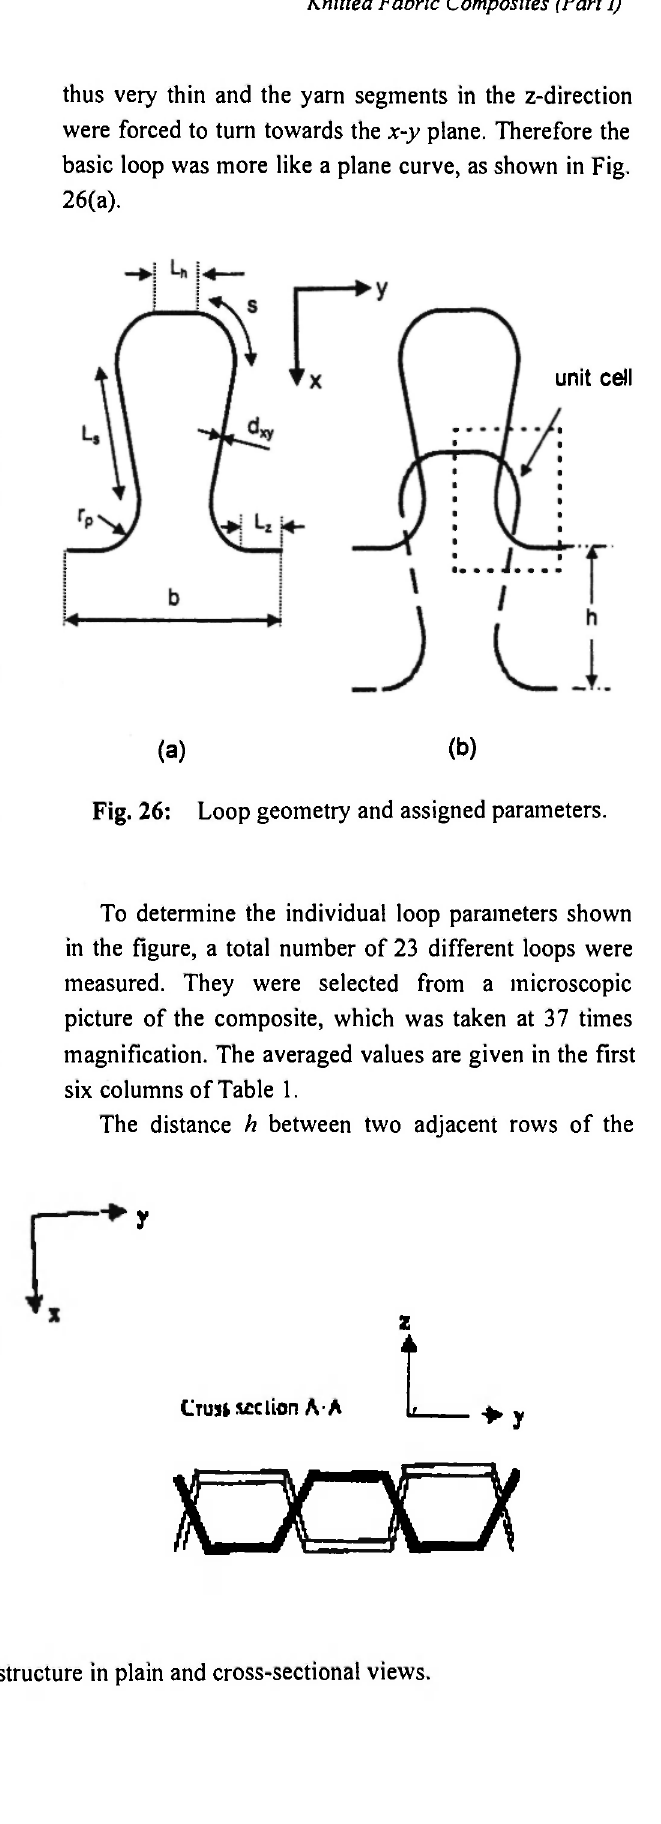
Fig. 25: Schematic interlock knit structure in plain and cross-sectional